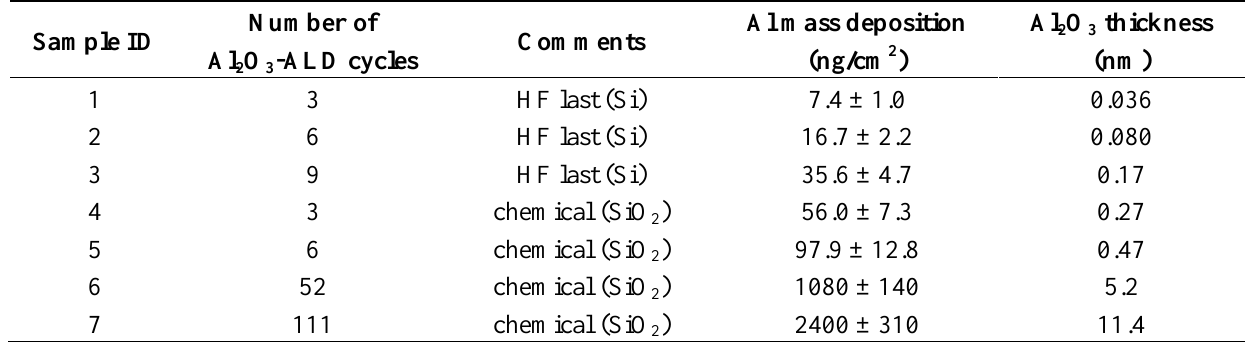
of the samples ID4–ID7 (sample set 1) obtained by 2